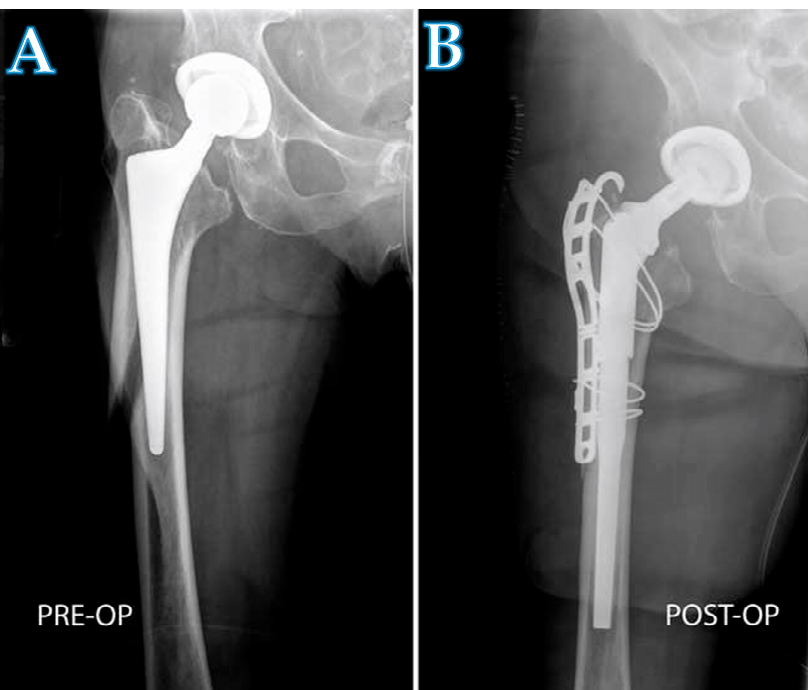
Figure 3. A radiograph showing a patient with a periprosthetic fracture ( A ), and the same patient after being treated with a modular stem ( B ). The implantation of the long modular stem and the reduction of the fracture was performed with a proximal and distal extension of the DAA .